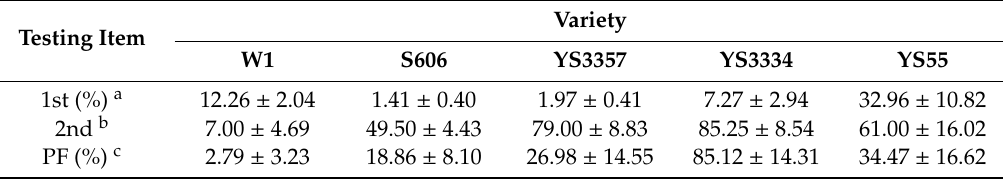
Table 3. Agrobacterium -mediated transformation (ATMT) transformation efficiency of different L. edodes variants.